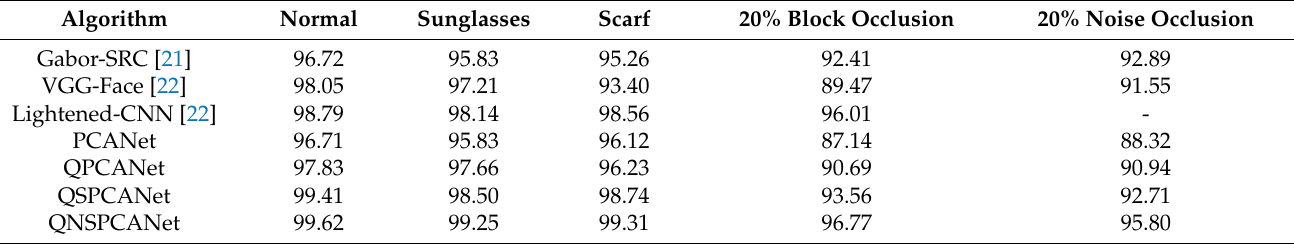
Table 3. The correct recognition rate of each algorithm in AR dataset under different occlusion conditions